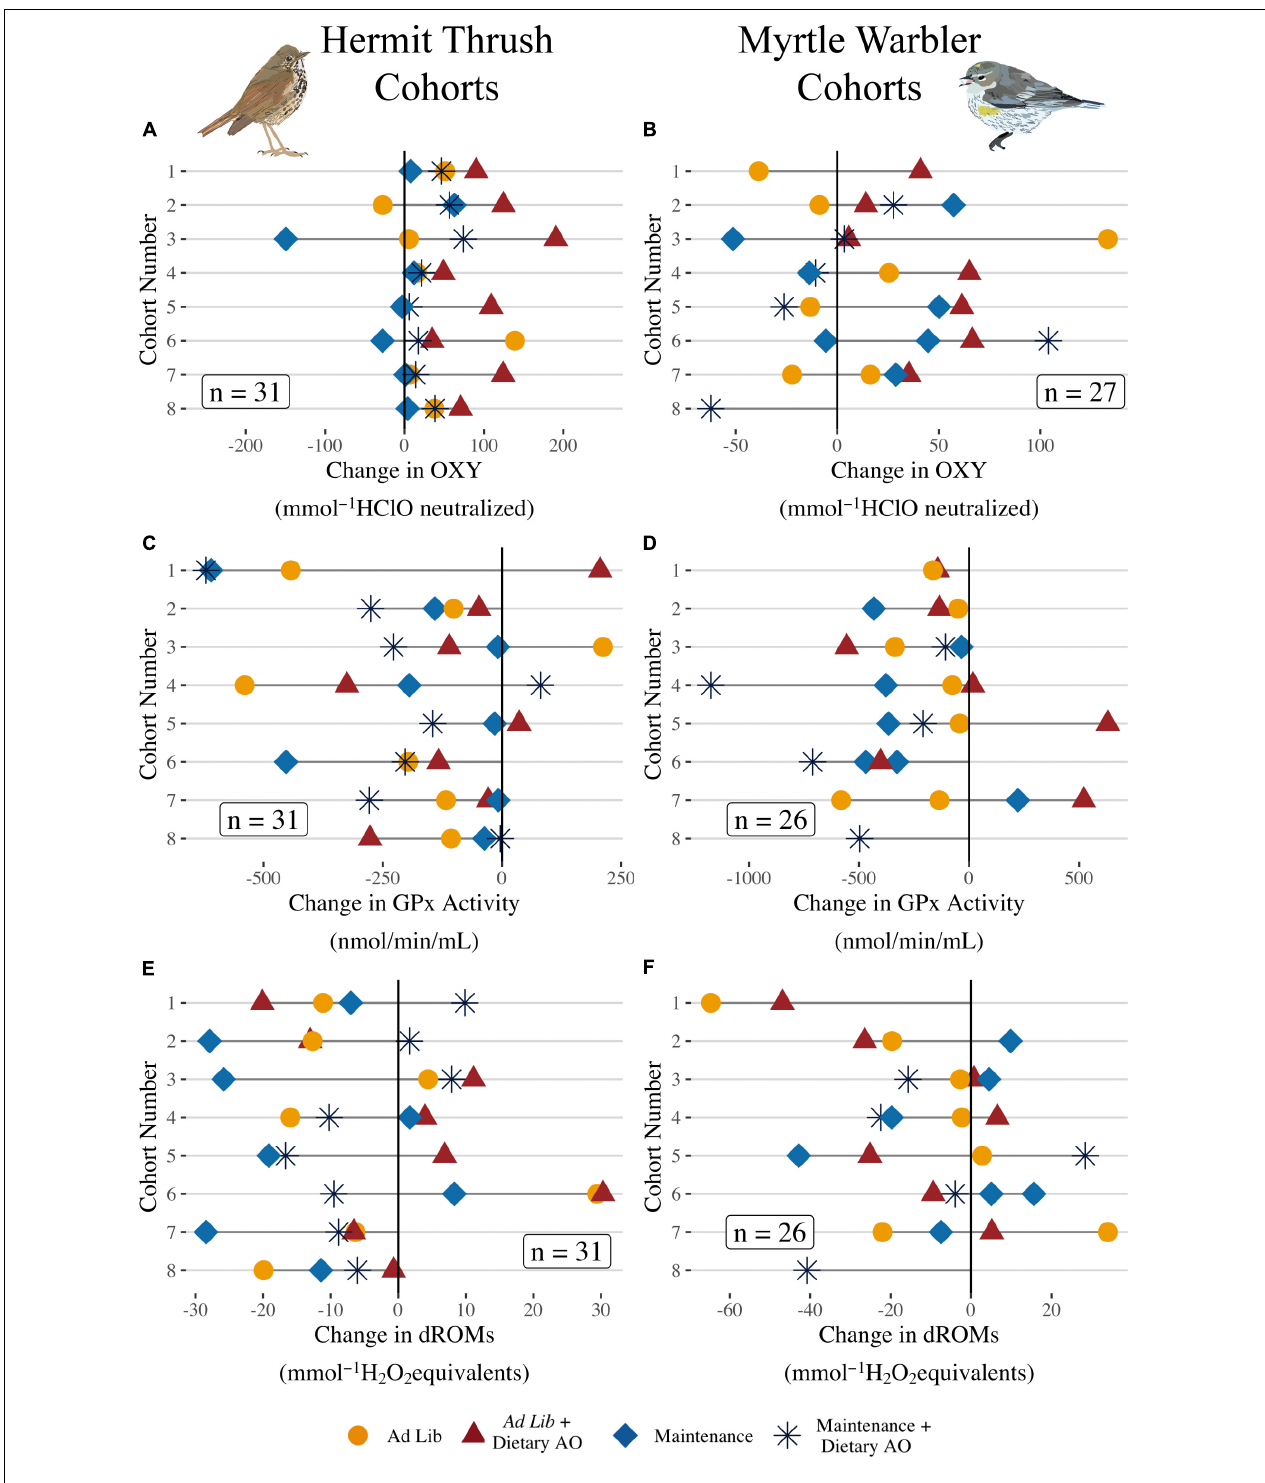
FIGURE 4 | (A,B) Change in plasma non-enzymatic antioxidant capacity (OXY), (C,D) erythrocyte glutathione peroxidase activity (GPx), and (E,F) plasma oxidative damage (dROMs) for each individual fed ad lib without supplemental polyphenols (light red) or with supplemental polyphenols (dark red), or at maintenance levels without supplemental polyphenols (light blue), or with supplemental polyphenols (dark blue) during captivity by cohort. Cohorts caught later in the season have higher numbers. Each dot represents an individual and the line indicates the magnitude of change during captivity (sample at release—sample at capture). Labels indicate samples sizes for each